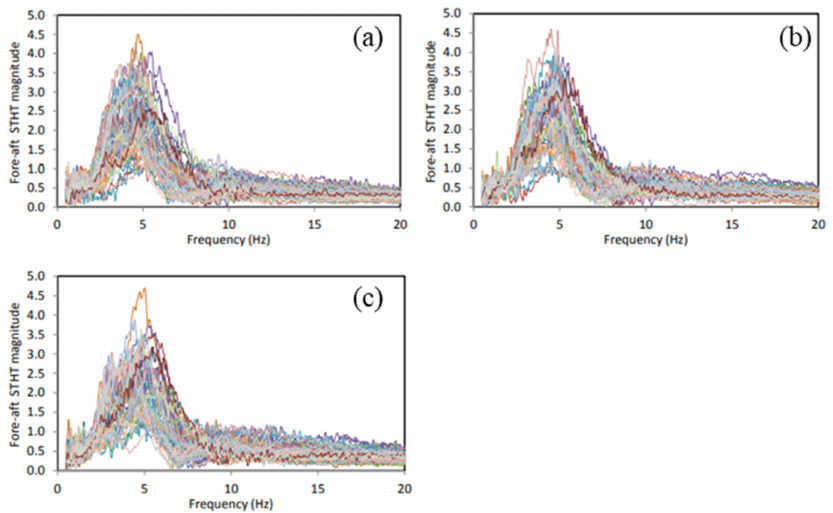
Figure 5. Fore-aft STHT magnitude responses of 58 participants seated without back support under 0.50 m/s 2 RMS excitation: ( a ) seat A; ( b ) seat B; and ( c ) seat